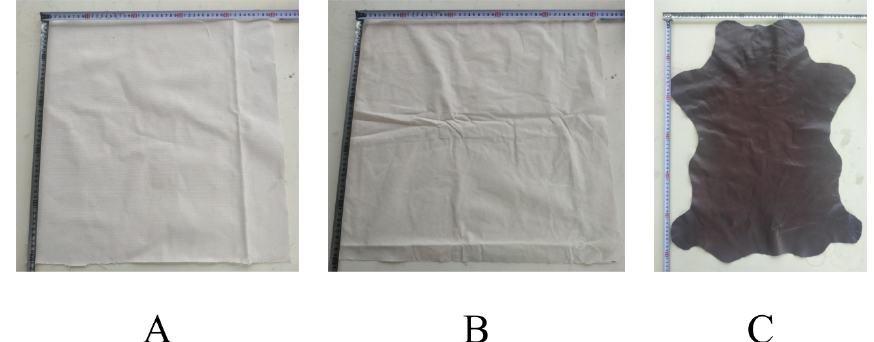
Figure 14. The captured object.